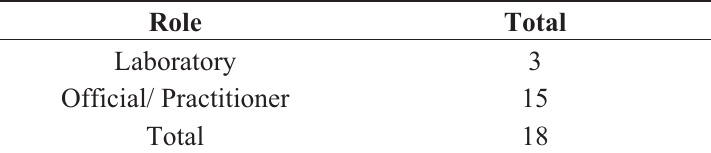
Table 2. Role of